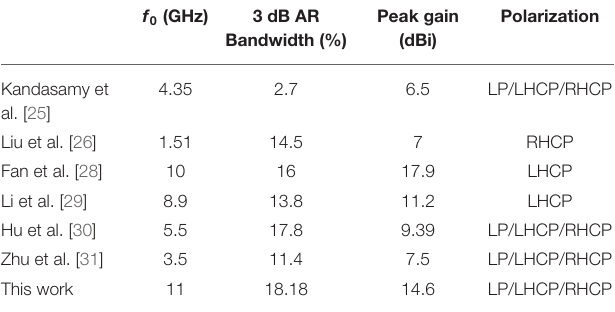
TABLE 1 | Comparison of some published polarization reconfigurable antennas and our work.